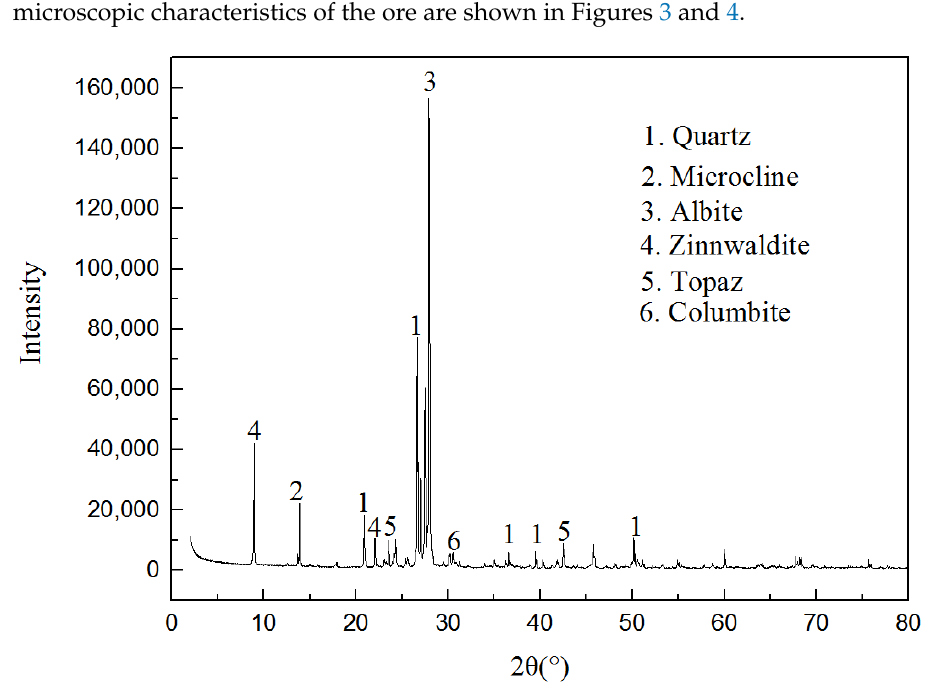
Table 1. Chemical analysis of ore sample.